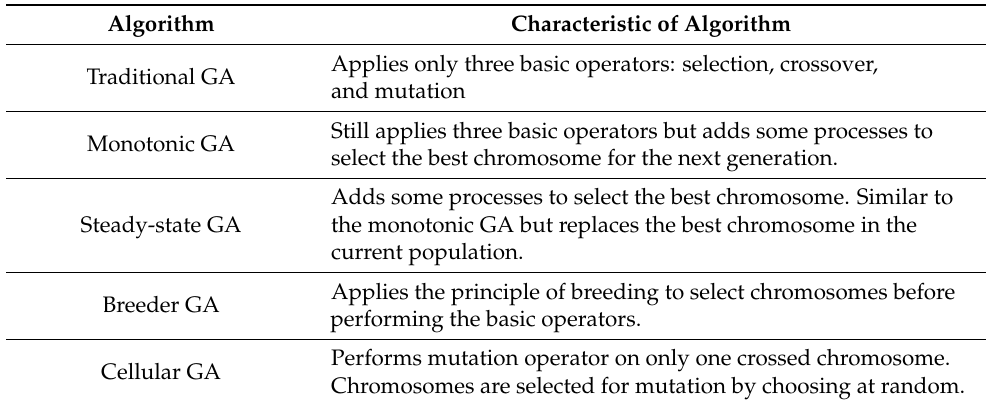
Table 1. Comparison of GA-based